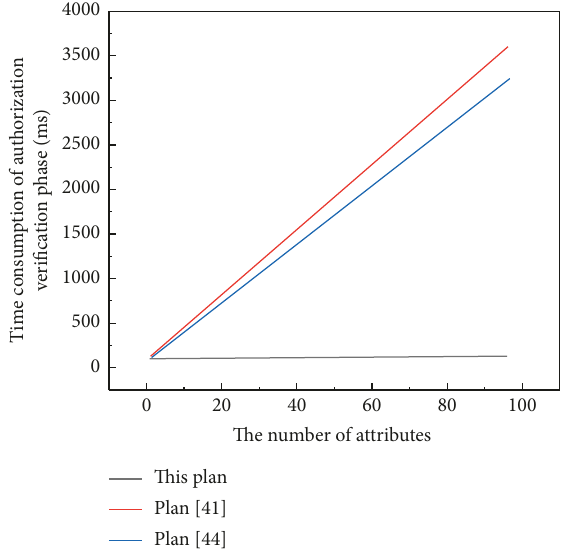
Figure 5: Time consumption of authority verification.